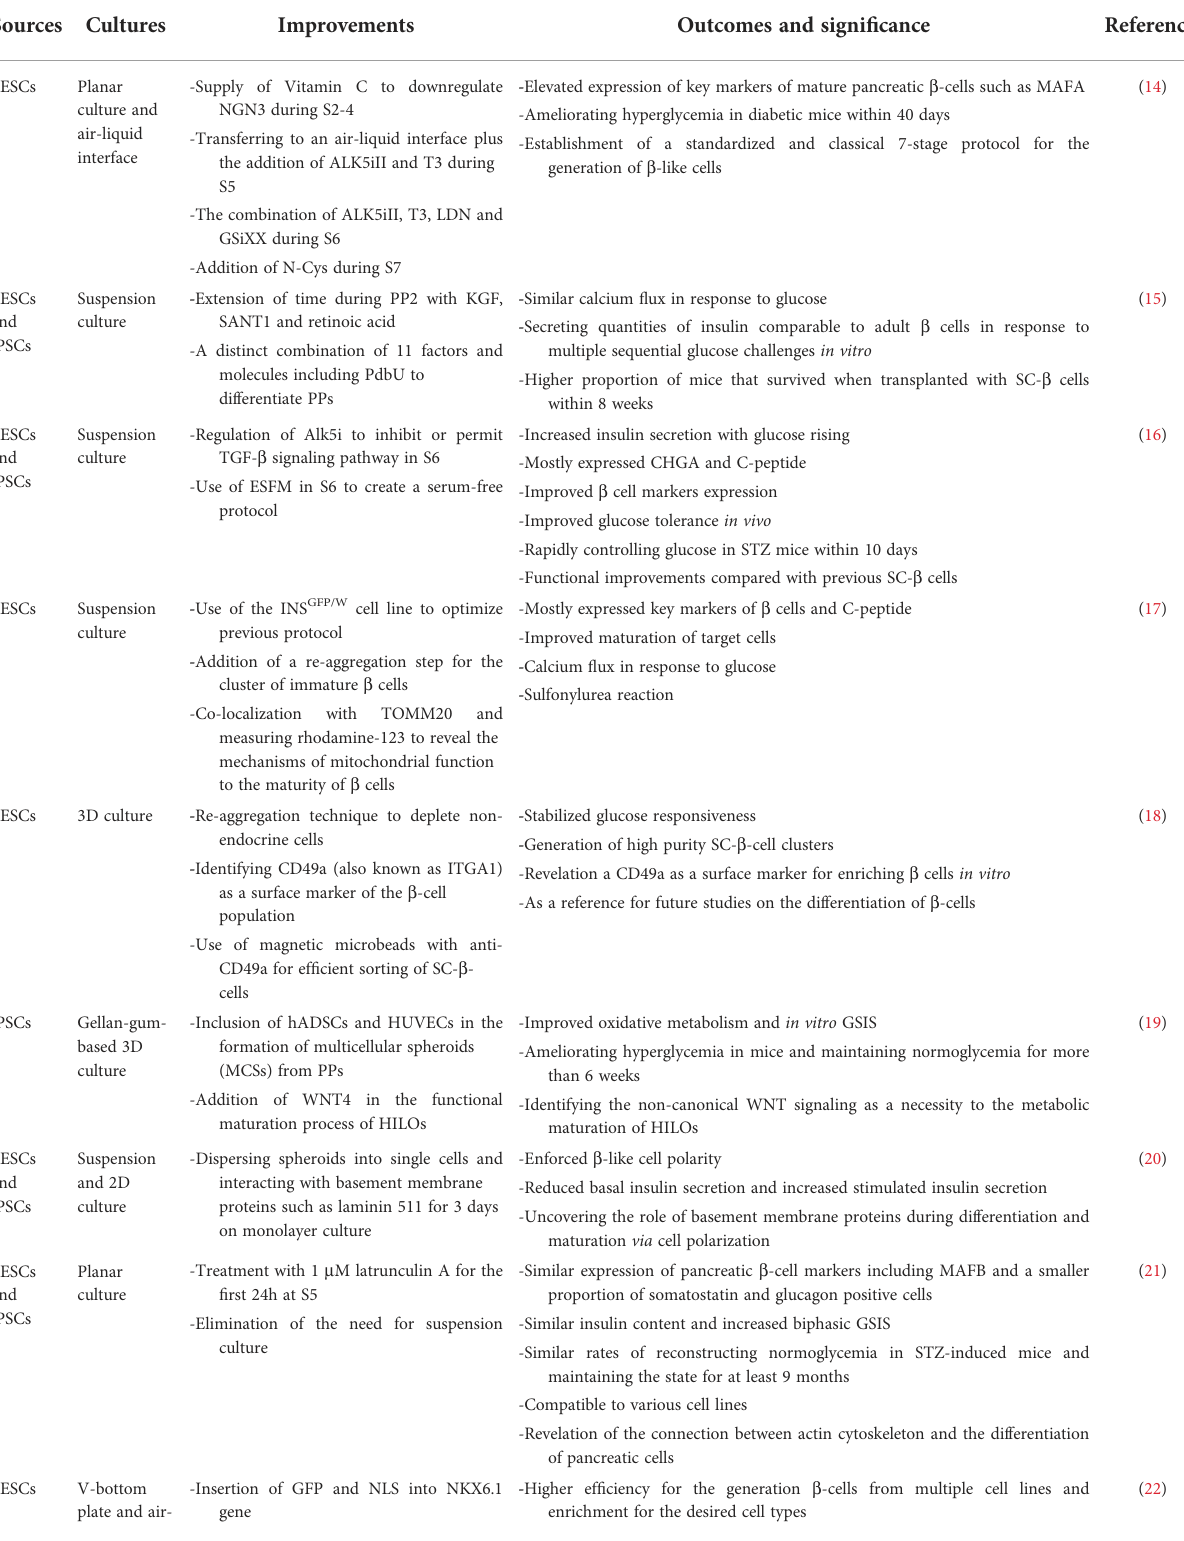
TABLE 1 Overview of protocols for the generation of stem cell-derived b -cells. Sources